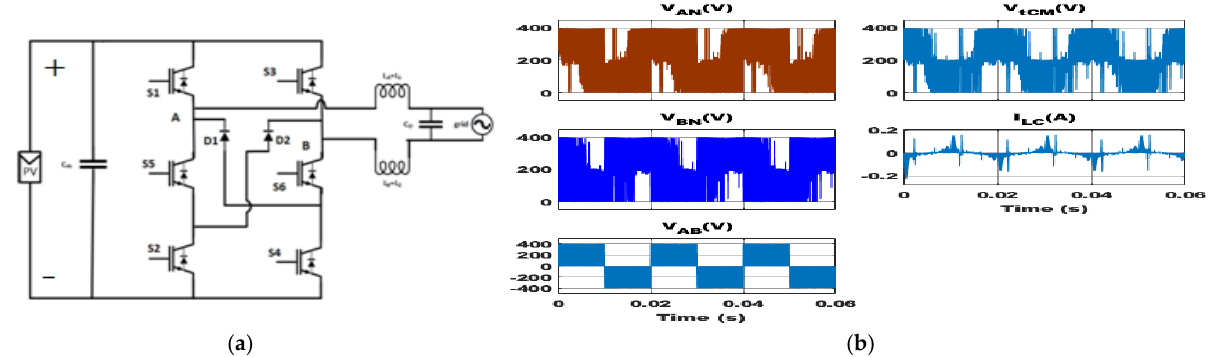
Figure 12. H6-II topology: ( a ) circuit structure; ( b ) simulation results.